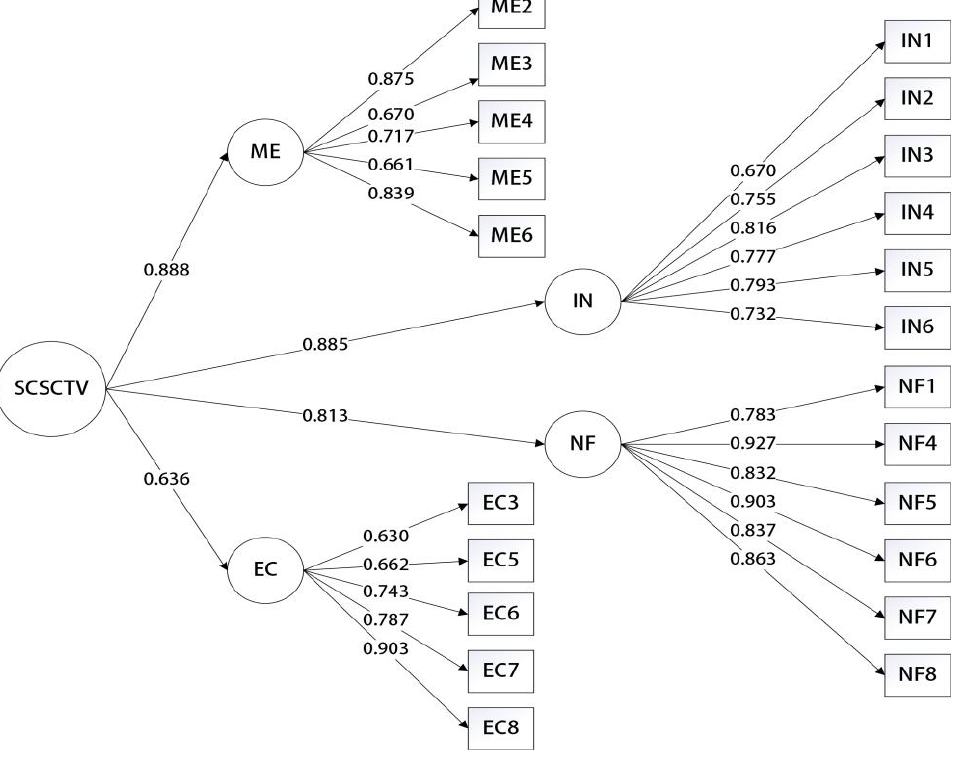
Table 6. Fit statistics for SCSCTV confirmatory factor analysis.